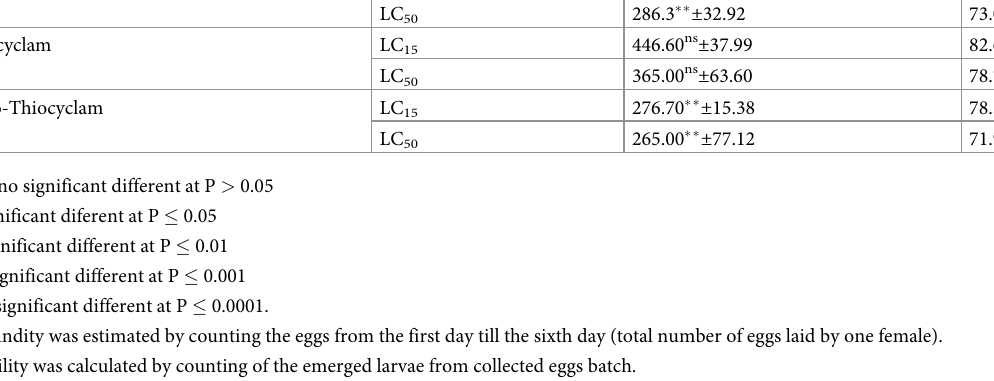
of chlorantrani- 50 15 of thiocyclam, and both the 15